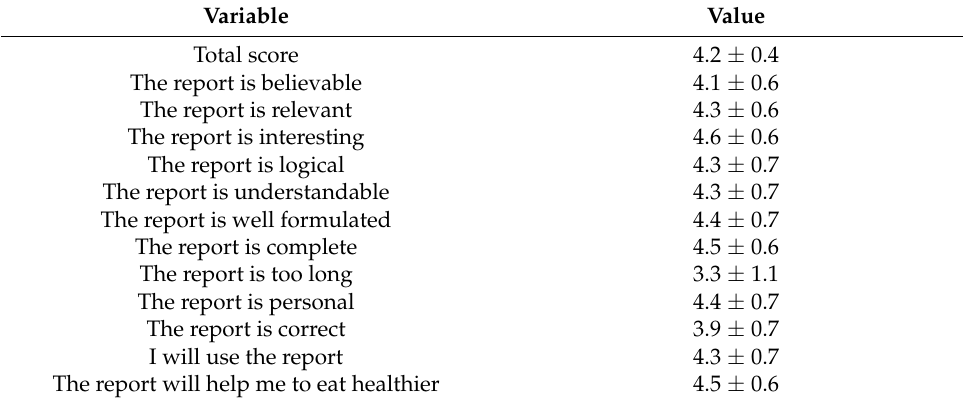
Table 3. Acceptability scores of the MDHQ feedback report ( n = 255) 1